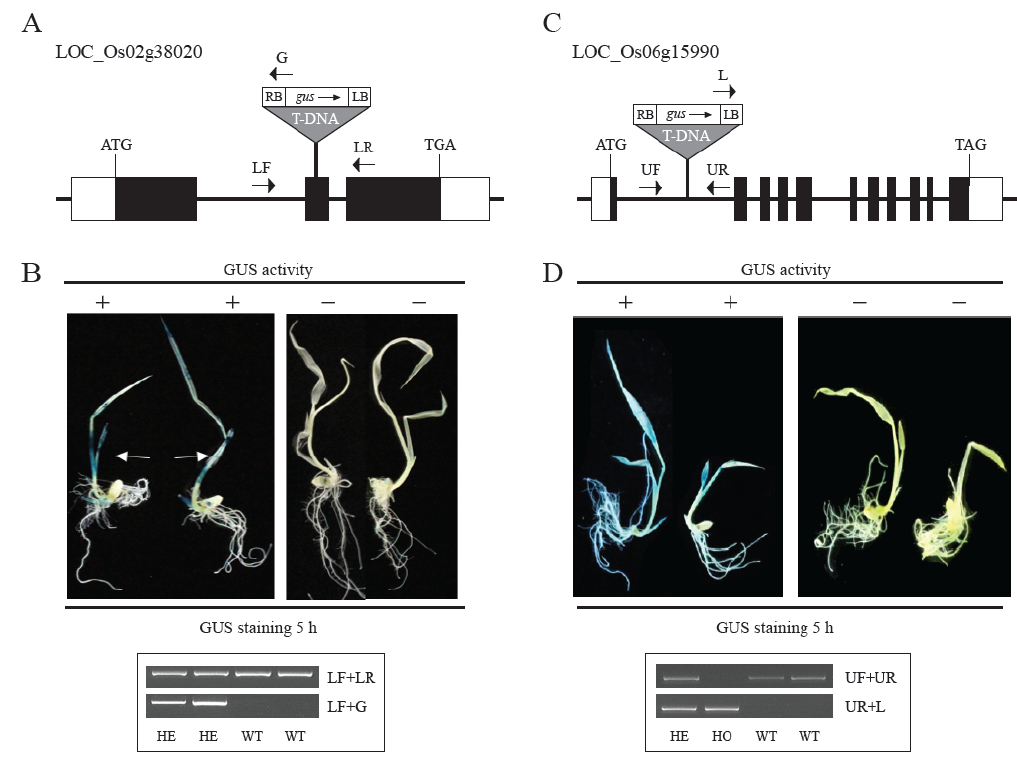
Figure 3. Confirmation of organ-specific genes using the promoter trap system. Schematic diagram of the T-DNA insertion site in LOC_Os02g38020 of PFG 1C-011049 ( A ) and LOC_Os06g15990 of PFG 3A-51959 ( C ). Black boxes represent exons; white boxes represent untranslated regions (UTRs); lines between boxes, represent introns; the gray triangle represents T-DNA insertion; small arrows, represent gene-specific primers for genotyping of the tagged gene. ATG and TGA indicate start and stop codons, respectively. GUS expression analysis and genotyping were performed for two PFG lines ( B , D ). GUS expression patterns were observed in leaves (indicated by arrows ( B ), and whole plants ( D )). Genotyping identified wild-type, heterozygous, and homozygous progenies with T-DNA. WT, wild-type segregants of T-DNA insertional line; HO, homozygote; HE, heterozygote. The primer sequences are indicated in Table S5: LF, leaf forward primer, LR, leaf reverse primer; UF, ubiquitous forward primer; UR, ubiquitous reverse primer; L, Left border primer; G, GUS primer.